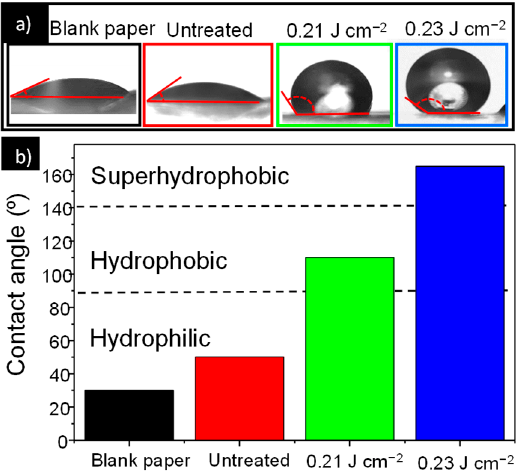
Figure 4. ( a ) Photographs of water droplet shape on the untreated and laser treated ZnO screen printed films. ( b ) Contact angle measured for untreated and laser treated samples.